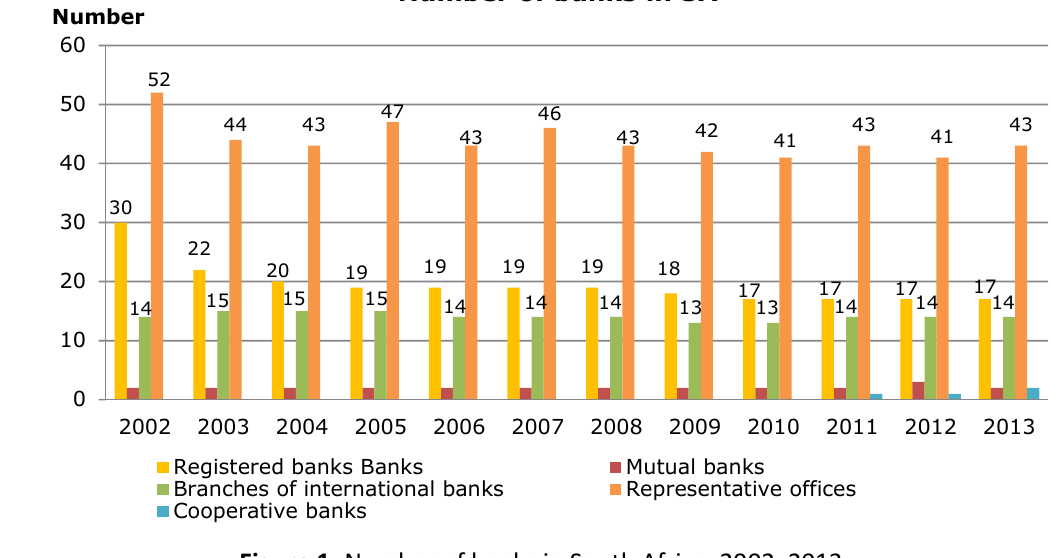
Figure 1. Number of banks in South Africa, 2002–2013